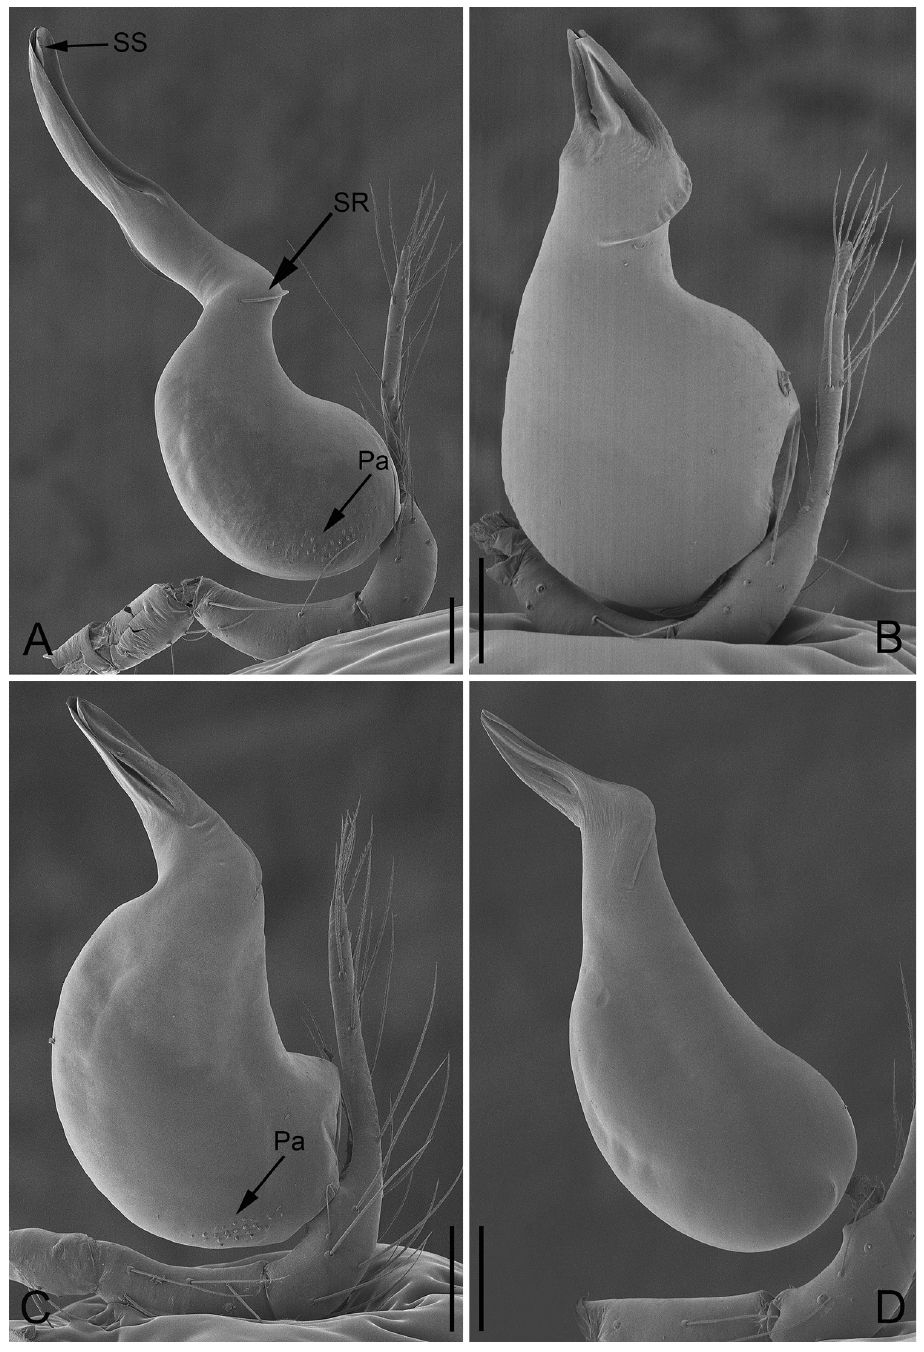
Figure 8. Retrolateral view of male palp of P. bailongensis ( A ); P. cunfengensis sp. n. ( B ); P. podiensis sp. n. ( C ); P. qingfengensis sp. n. ( D ). Scale bars: 0.1